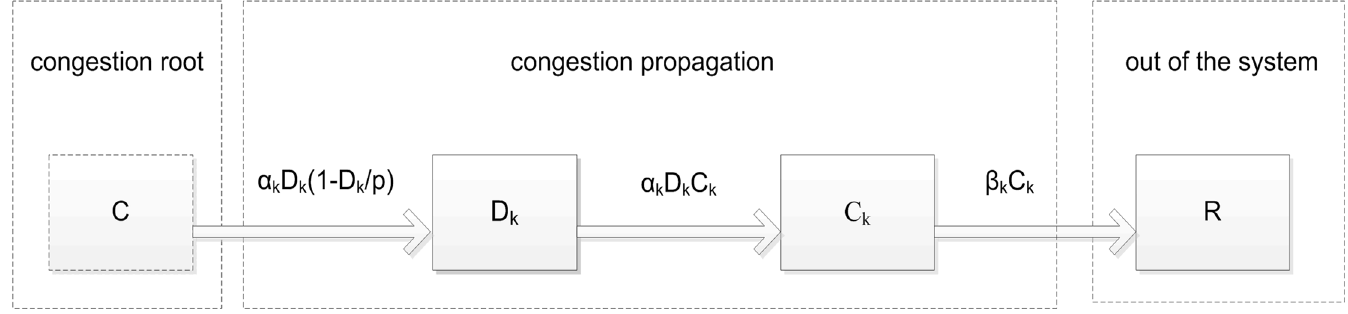
Fig 2. Congestion propagation